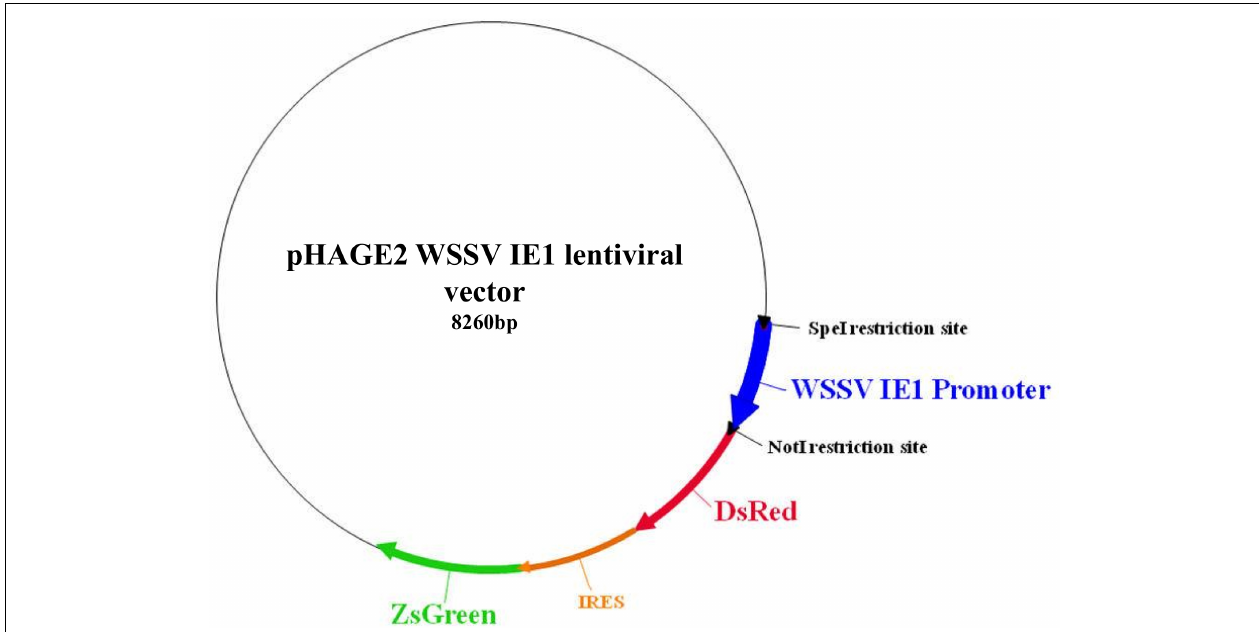
FIGURE 1 | Plasmid map of the novel WSSV IE1 lentiviral plasmid after insertion of the WSSV IE1 promoter region into a pHAGE2 lentiviral plasmid. The sequence of the human EF1 α promoter was restricted out by using Spe I and Not I restriction enzymes, followed by ligation of the WSSV IE1 sequence into the lentiviral plasmid (dark blue arrow). Functional elements are shown, including the relevant restriction sites and the red fluorescent (DsRed) and green fluorescent (ZsGreen) coding genes under the regulation of the WSSV IE1 promoter. The novel lentiviral plasmid was sequenced, aligned, and verified.